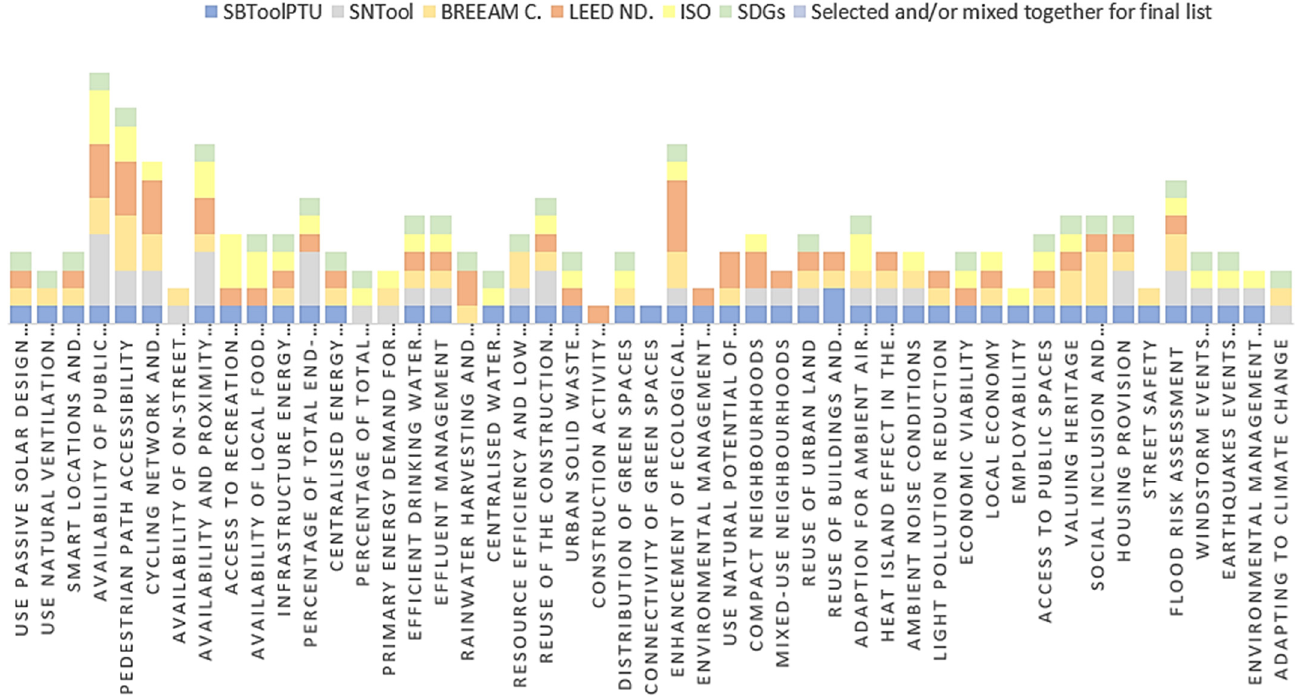
Figure 14. Frequency distribution of each indicator included in the four sustainability tools: SBTool PT _Urban (2018), SNTool Min (2020), BREEAM-C (2012), LEED-ND (2018), and supported by ISO 37120, and/or SDGs.